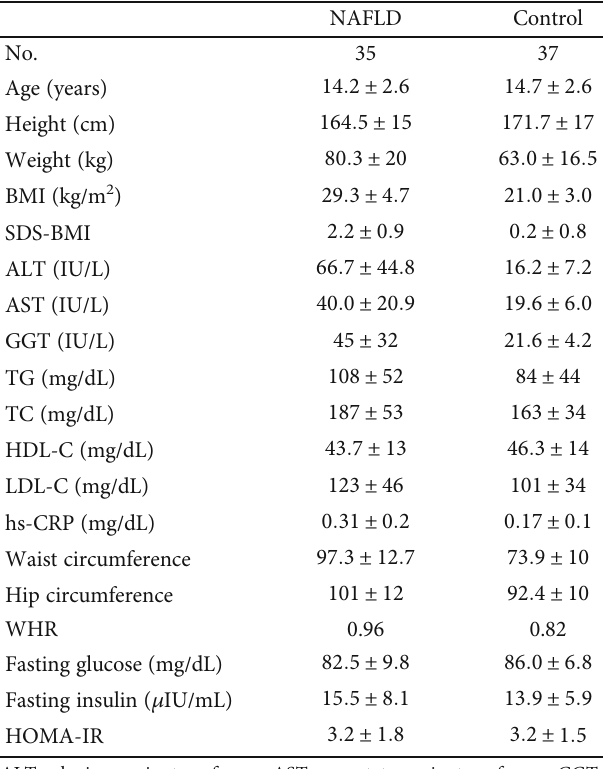
Table 1: Anthropometric and clinical characteristics of the study (NAFLD) and control